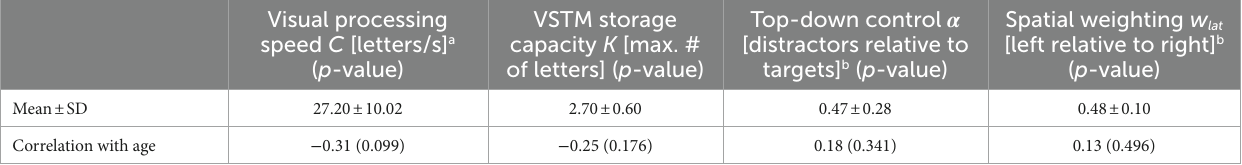
TABLE 3 TVA parameters and their correlation with age. Visual processing speed C [letters/s] a